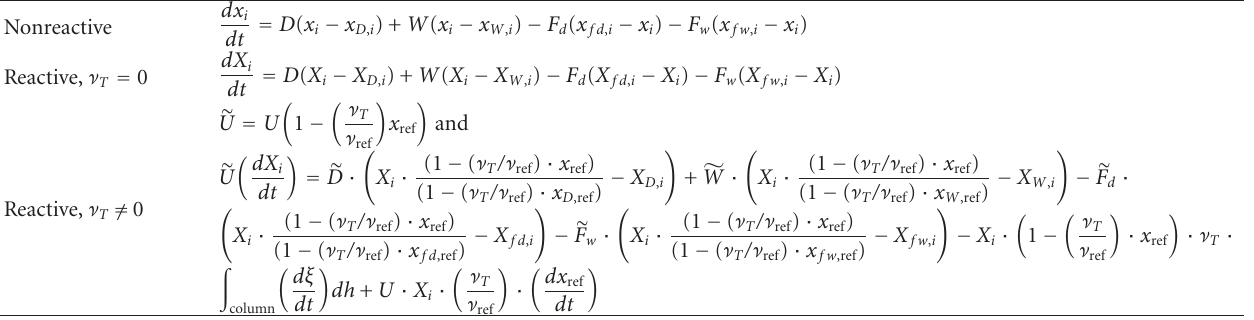
Table 2: Model equations of vessel path for single-reaction